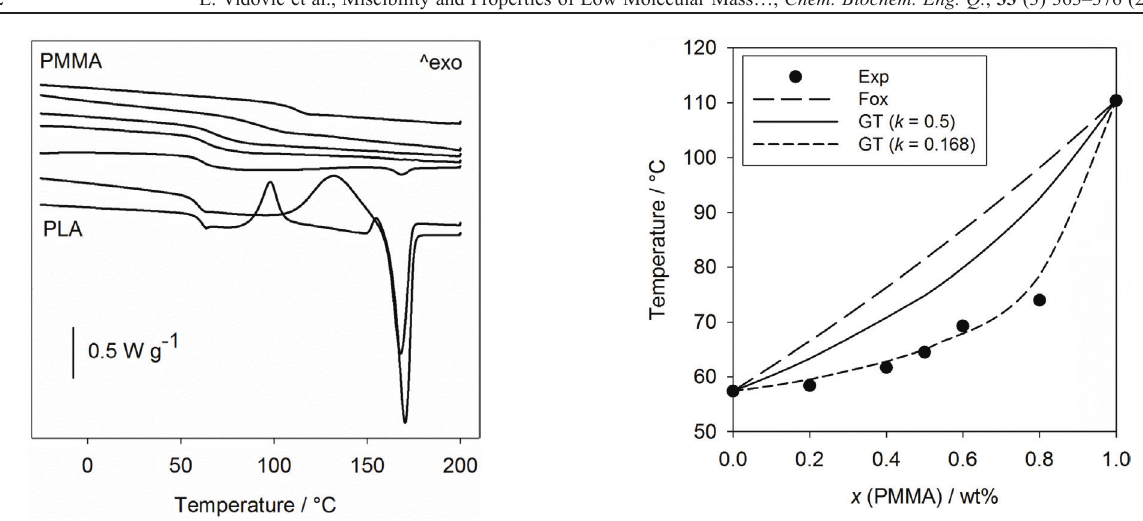
Fig. 8 – Glass transition temperatures of polymer blends with fitted Fox and Gordon-Taylor (GT) models